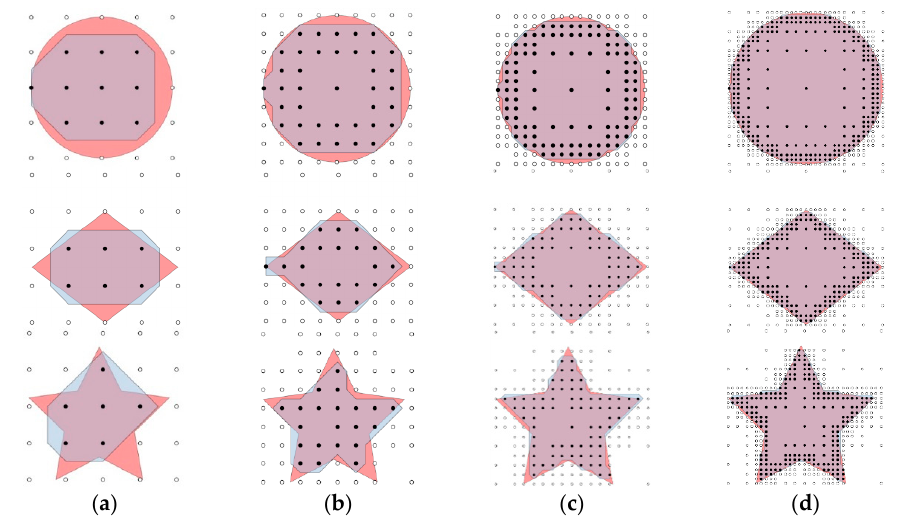
Figure 7. Different max levels for the proposed method with initial grid size = 100. ( a ) level = 1; ( b ) level = 2; ( c ) level = 3; ( d ) level = 4.